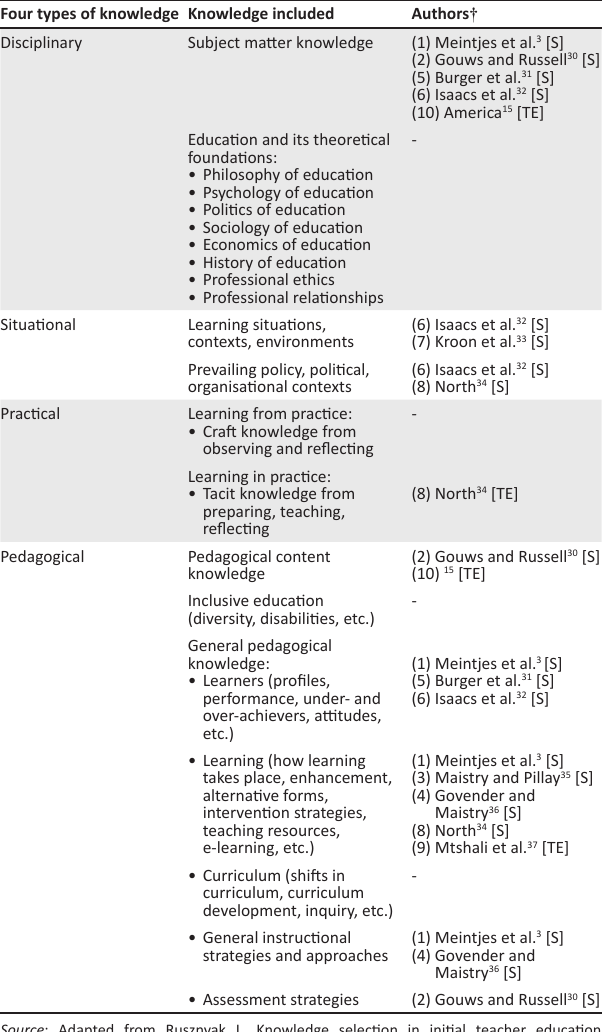
TABLE 1: Summary of results: Business studies education. 17,24 Four types of knowledge Knowledge